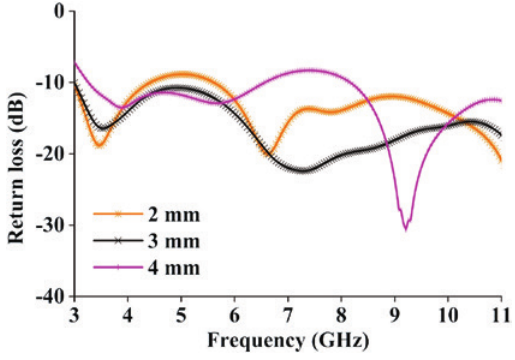
. Figure 9: Measured and simulated return loss of the proposed W antenna.